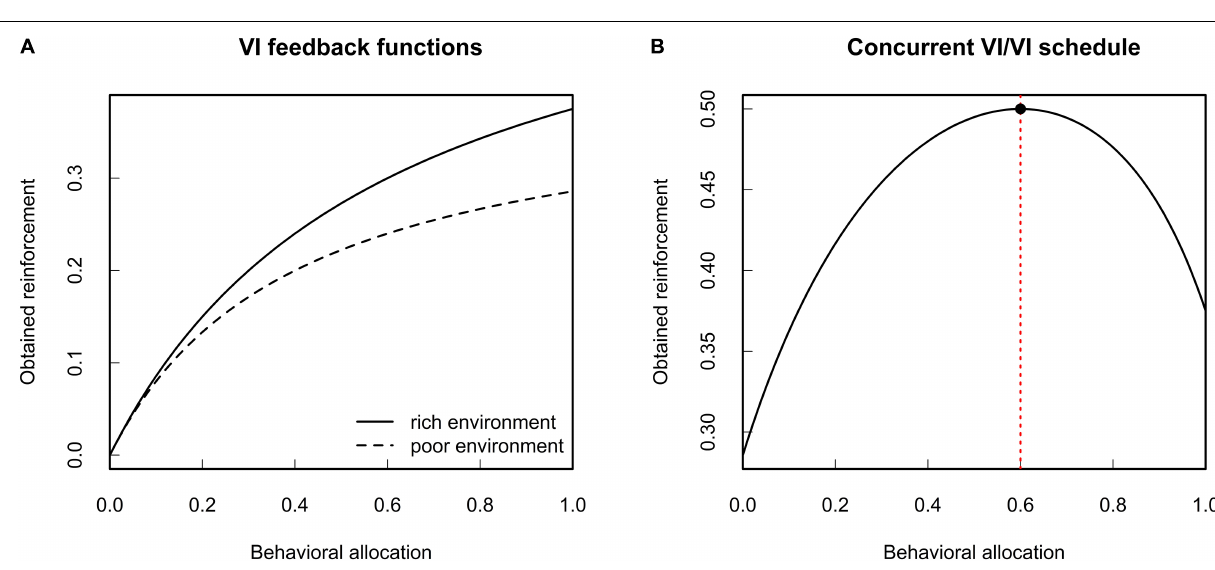
FIGURE 2 | Expected environmental feedback from variable interval (VI) schedules of reinforcement. (A) Two VI feedback functions for different average time between reinforcements. (B) Total expected reinforcement obtained from a concurrent VI/VI schedule of reinforcement. The red dotted line indicates the point where the marginal gain in reinforcement is zero. Given constant fitness functions, this coincides with the maximum amount of obtained reinforcement in terms of absolute reinforcer value (see Borgstede, 2020 for